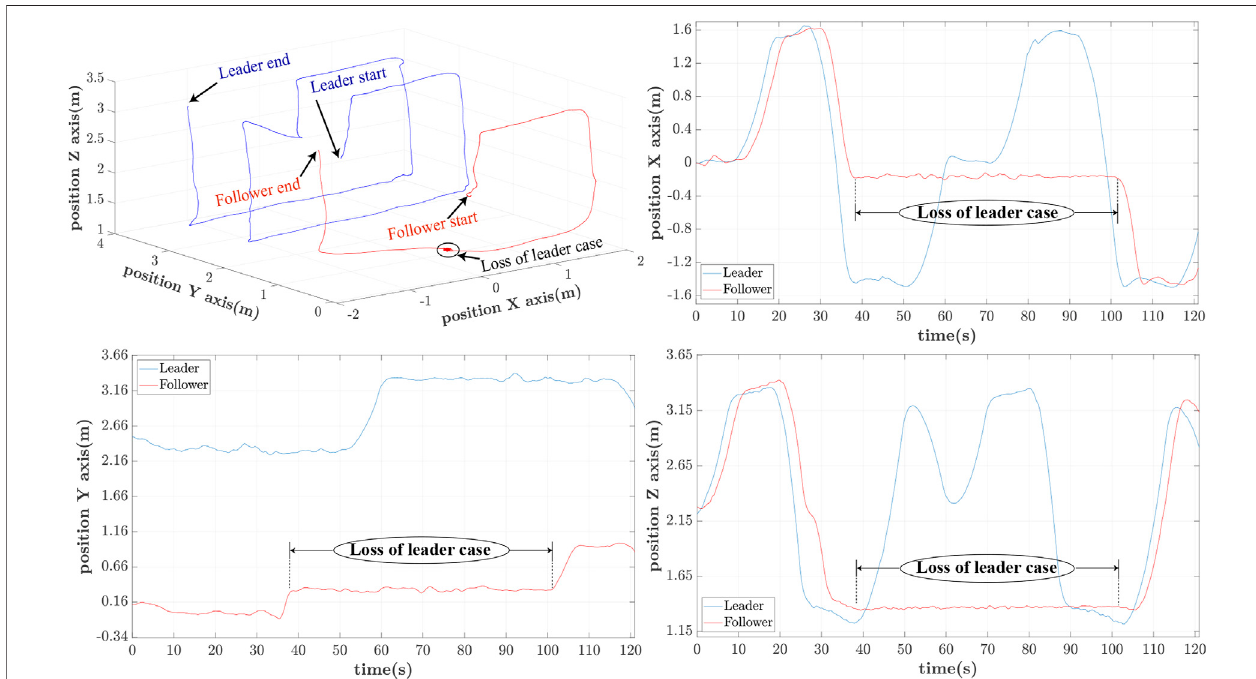
FIGURE 12 | 3D Leader/Follower trajectories with h (cid:2) 1.25s delay.